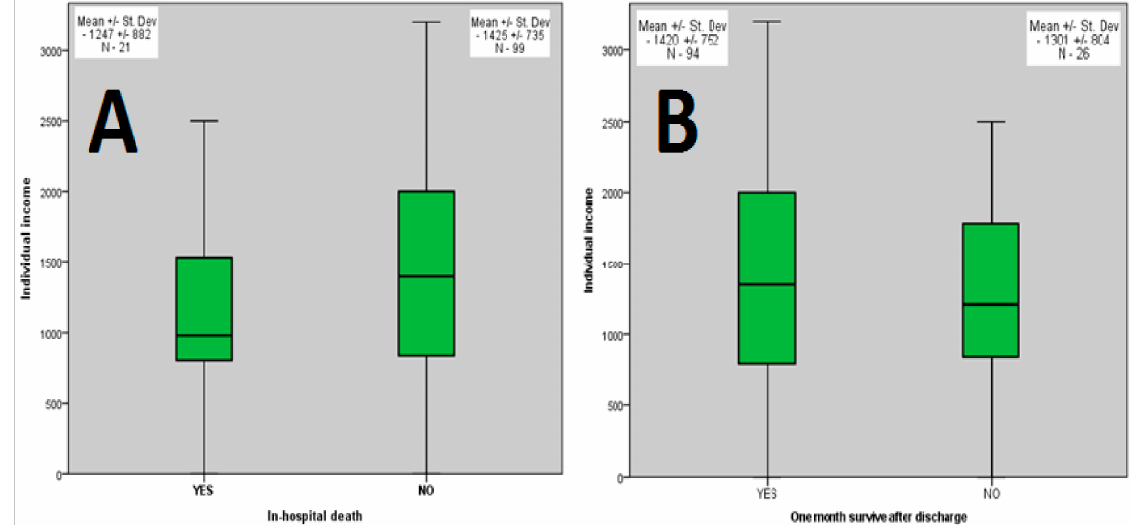
Figure 1. Impact of individual income on in-hospital ( A ) and on 1-month follow-up ( B ) survivability rates in patients with acute